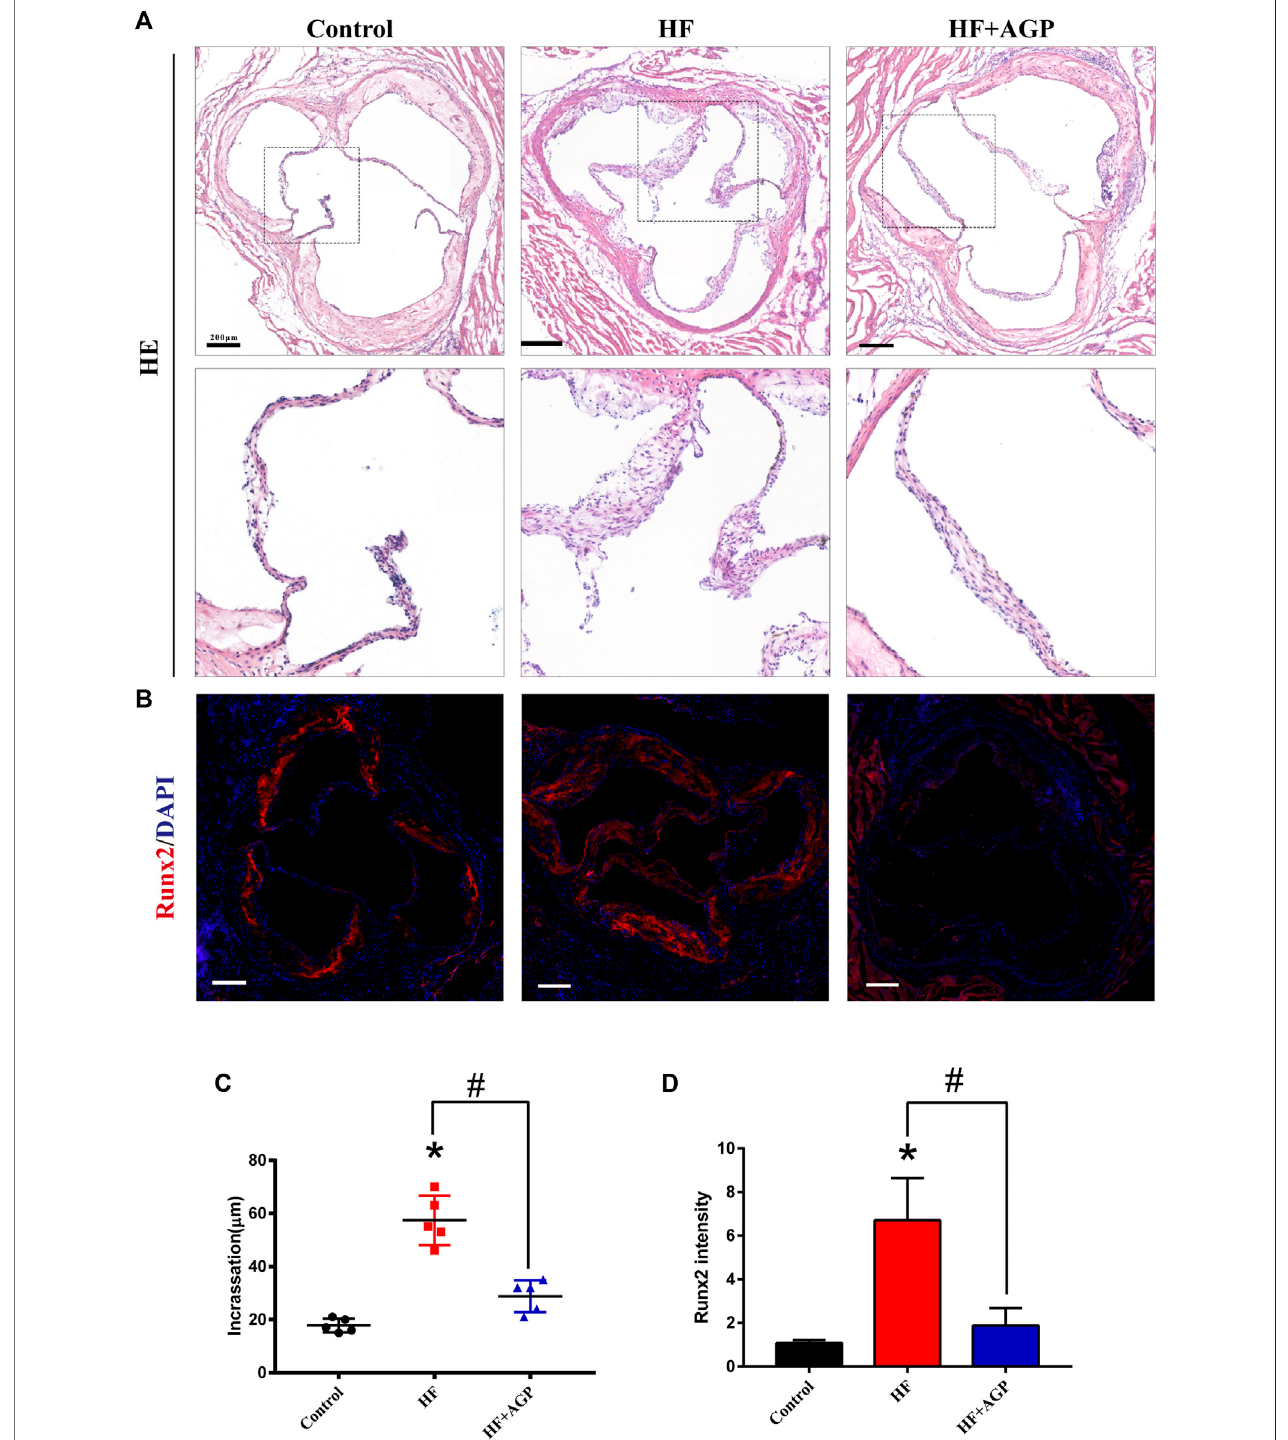
FIGURE 5 | AGP delayed aortic valve disease in high-fat diet-fed (HF) mice. (A) Hematoxylin and eosin (HE) staining of HF mice aortic valves with or without AGP treatment(bar=100 μ m). (B) Runx2immuno fl uorescencestainingofHFmiceaorticvalveswithorwithoutAGPtreatment(bar=100 μ m). (C) Statisticalanalysisofmice aortic valve calci fi c incrassation. (D) Statistical analysis of mice aortic valve Runx2 fl uorescence intensity. (*) p < 0.05 (vs control group) and (#) p < 0.05 (vs HF group) indicate a signi fi cant difference.